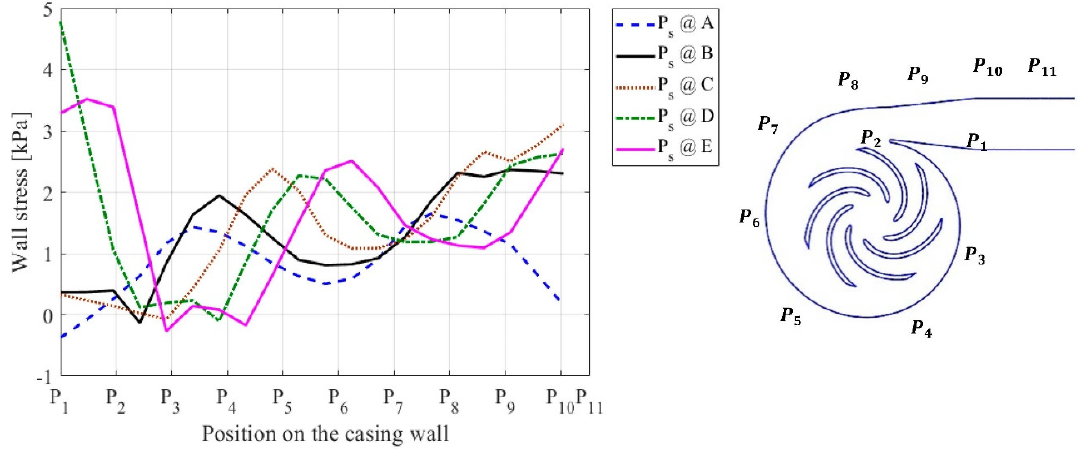
Figure 14. Variation of concentration of wall stresses along the casing wall with different solid particle sizes and distribution.